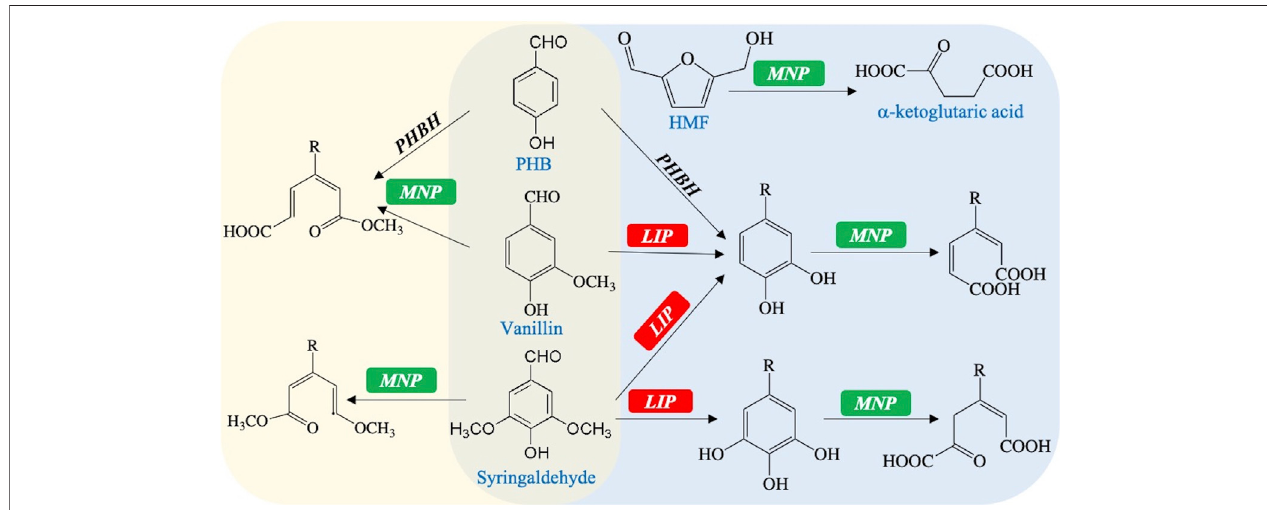
FIGURE 4 | Hypothetical model for the degradation of typical by-products mediated by MNP and VP : PHBH , para-hydroxybenzoate hydroxylase ( R. toruloides endogenous, gene symbol RHTO_07012); R represents the group of − CHO, − COOH, or − CH 2 OH.